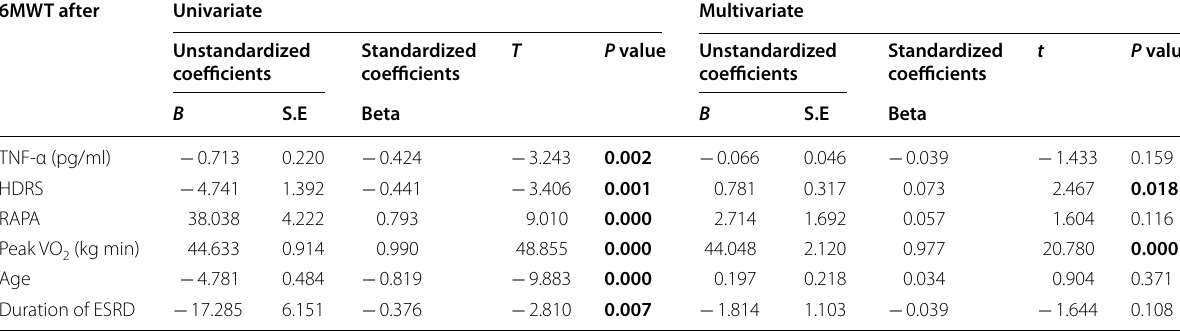
6MWT: six-min walk test, TNF-α: tumor necrosis factor alpha, HDRS: Hamilton Depression Rating Scale, RAPA: rapid assessment of physical activity, peak VO 2 : peak volume of oxygen consumption, ESRD: end stage renal disease Bold indicates statistical significance. P value > 0.05: non-significant; P value < 0.05: significant; P value < 0.01: highly